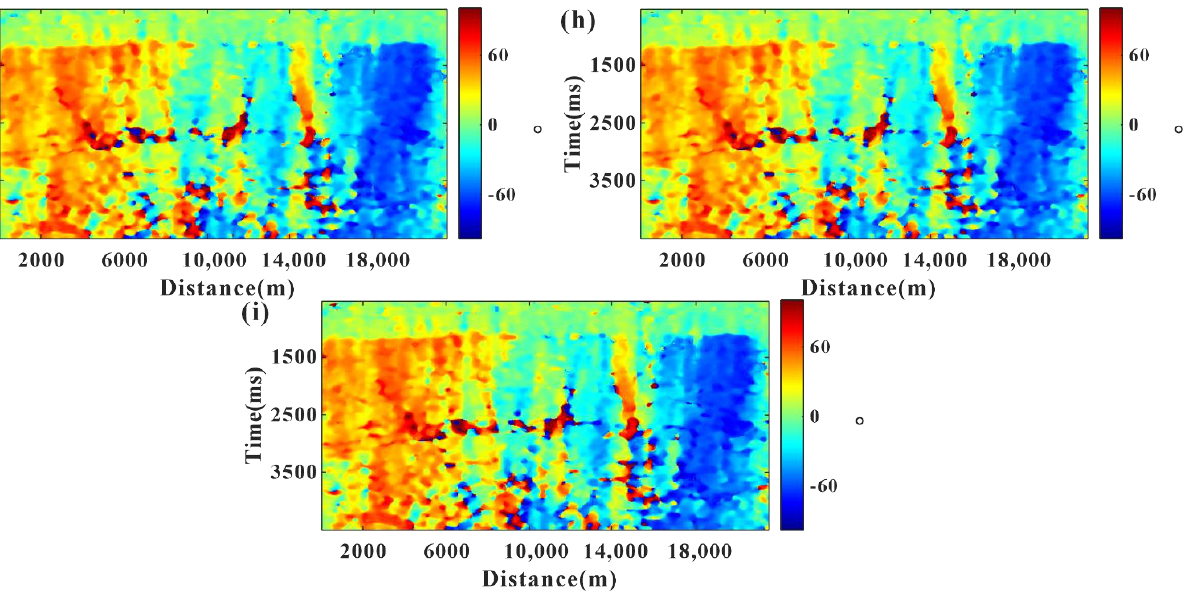
Figure 13. Estimation results of autocorrelation parameters of porosity, clay volume, and water saturation: ( a – c ) are the horizontal autocorrelation length of porosity, clay volume, and water saturation, respectively. ( d – f ) are the vertical autocorrelation length of porosity, clay volume, and water saturation, respectively. ( g – i ) are the autocorrelation angle of porosity, clay volume, and water saturation, respectively.